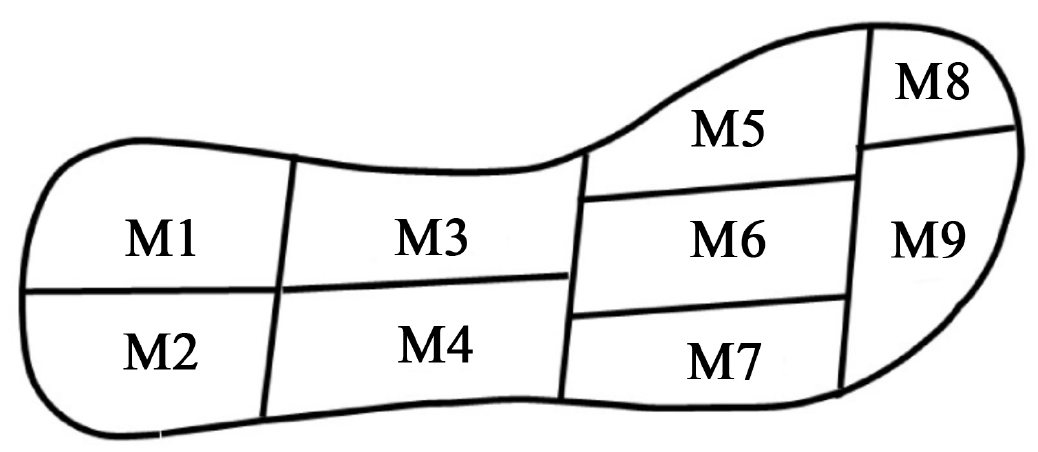
Fig. 1. Insole masks. M1 (medial heel), M2 (lateral heel), M3 (medial midfoot), M4 (lateral midfoot), M5 (medial forefoot), M6 (central forefoot), M7 (lateral forefoot), M8 (great toe), and M9 (lesser